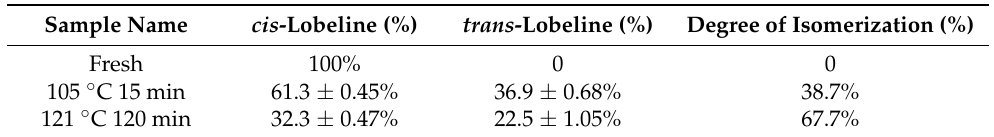
Table 1. The percentage content of trans -lobeline in the samples used to pharmacodynamic study ( n = 3).